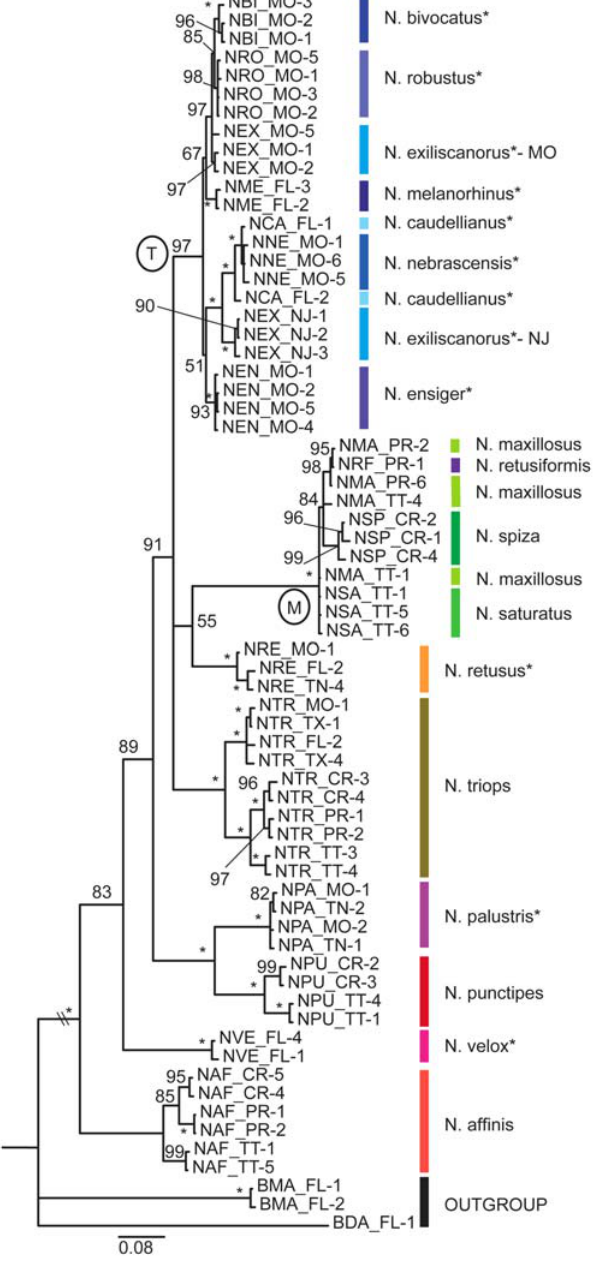
Figure 3. Phylogeny of Neoconocephalus based on a mitochon- drial gene. Bayesian phylogeny of Neoconocephalus using partial COI mtDNA sequences. Nodal support values are posterior probabilities in percent; asterisk indicate 100%. The temperate clade and the N. maxillosus clade are indicated by labels ‘T’ and ‘M’, respectively. Branch lengths drawn to scale. The taxa included in this tree are listed in Table S1. Asterisks at the species names indicates temperate life history. Species are indicated by colored